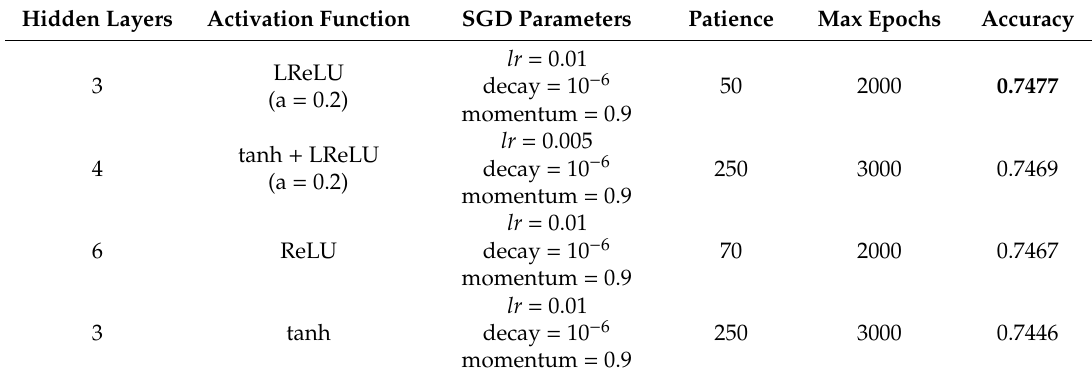
Table 24. Specifications of neural networks for which the highest values of classification accuracy were